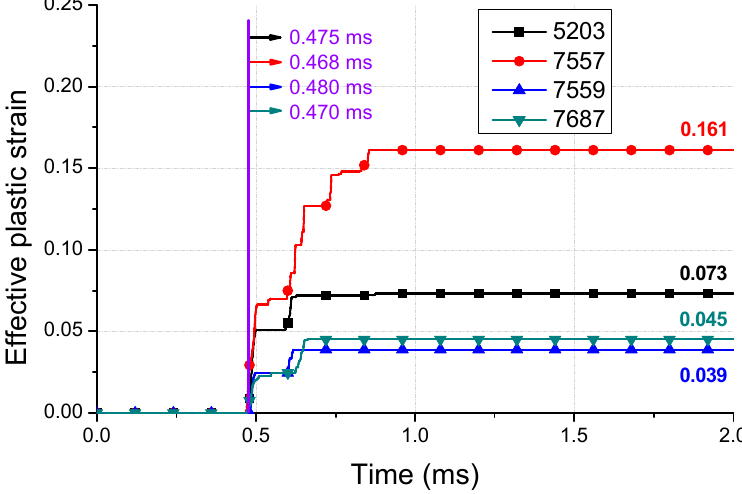
Micromachines 2019 , 10 , x FOR PEER REVIEW Figure 13. Effective plastic strain of haptic spring at steady state after impact (with number of elements).